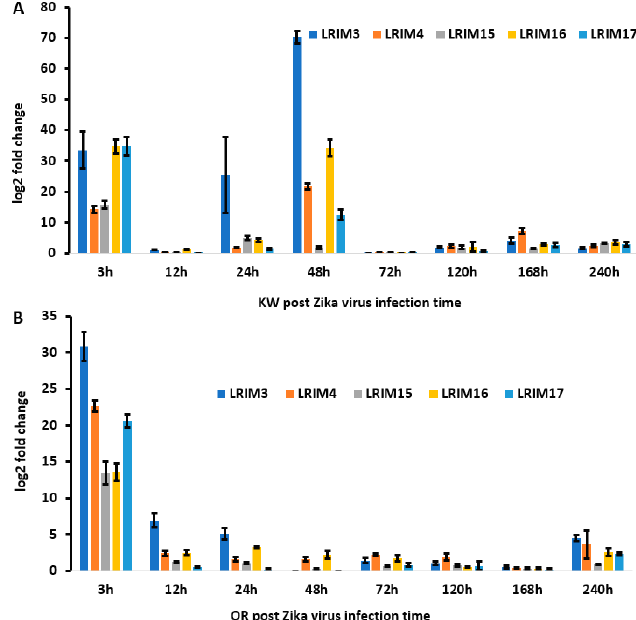
Figure 3. AaeLRIM3, AaeLRIM4, AaeLRIM15, AaeLRIM16, and AaeLRIM17 relative expression level fold changes in Aedes aegypti female infected with ZIKV. The fold change was calculated using the 2 [ − average ∆∆ CT] method. ∆ Ct (Control) = Ct ( AaeLRIM1 / AaeAPL1 ) – Ct ( AeaActin ); ∆ Ct (infected-ZIKV) = Ct ( AaeLRIM1 / AaeAPL1 ) − Ct ( AeaActin ); ∆∆ Ct = ∆ Ct (infected-ZIKV) − ∆ Ct (Control). The 3, 12, 24, 48, 72, 120, 168, and 240 h represented gene expression post infected with ZIKV. ( A ) KW strain female Ae. aegypti; ( B ) Orlando strain female Ae. aegypti